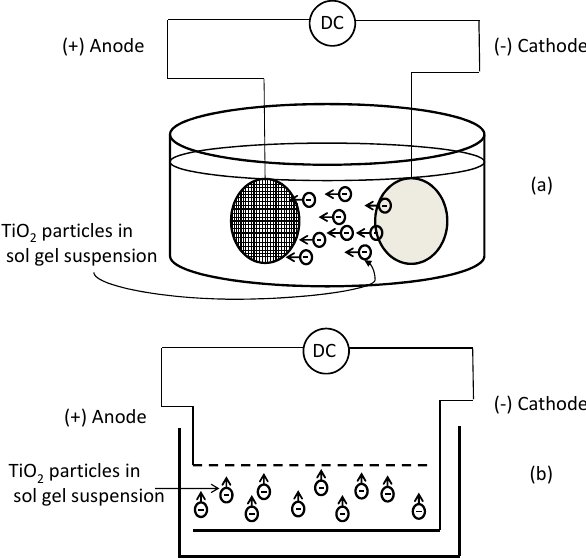
Figure 1. A schematic view of EPD cells. (a) A vertical coating setup for the small mesh discs. (b) A horizontal coating setup for the large-scale